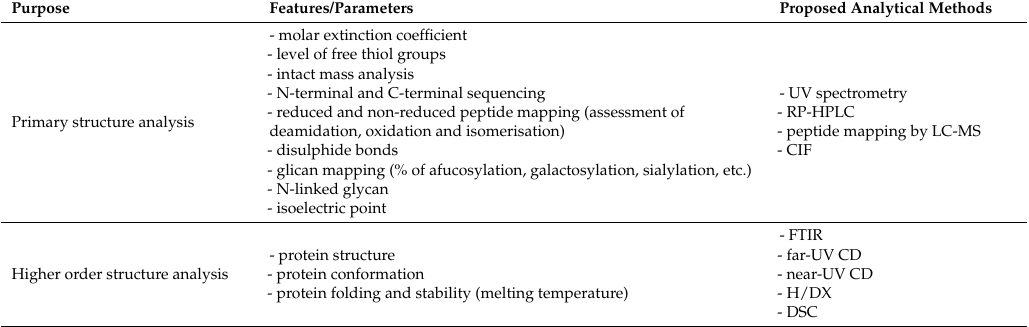
Table 2. Examples of comparable quality studies performed to demonstrate biosimilarity between the